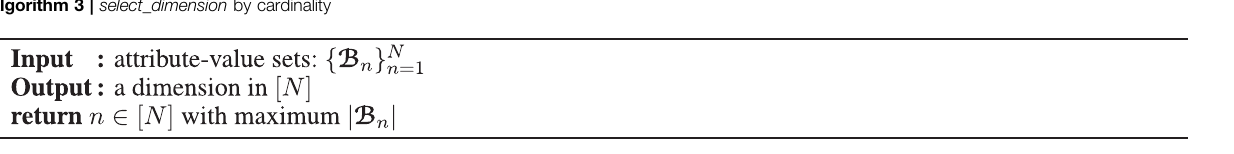
Algorithm 3 | select _ dimension by cardinality